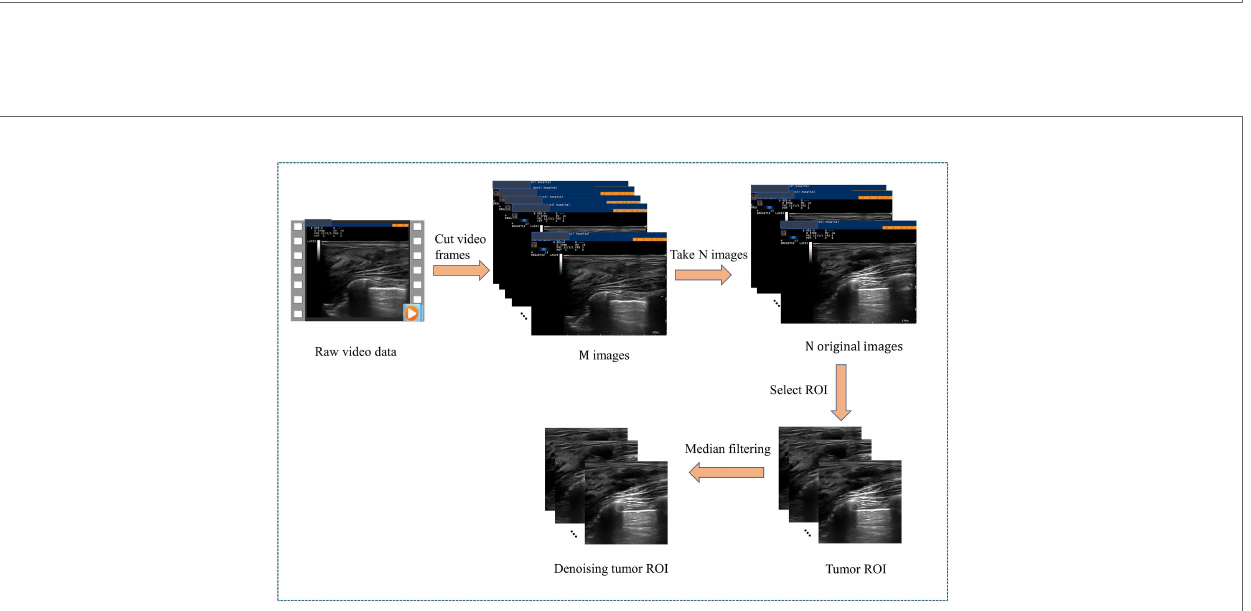
FIGURE 2 | Two sets of tumour US images corresponding to different stages of NAC. (A) a set of images of pCR. (B) a set of images of non-pCR. NACpre, US images before chemotherapy; NAC1, US images after the fi rst stage of